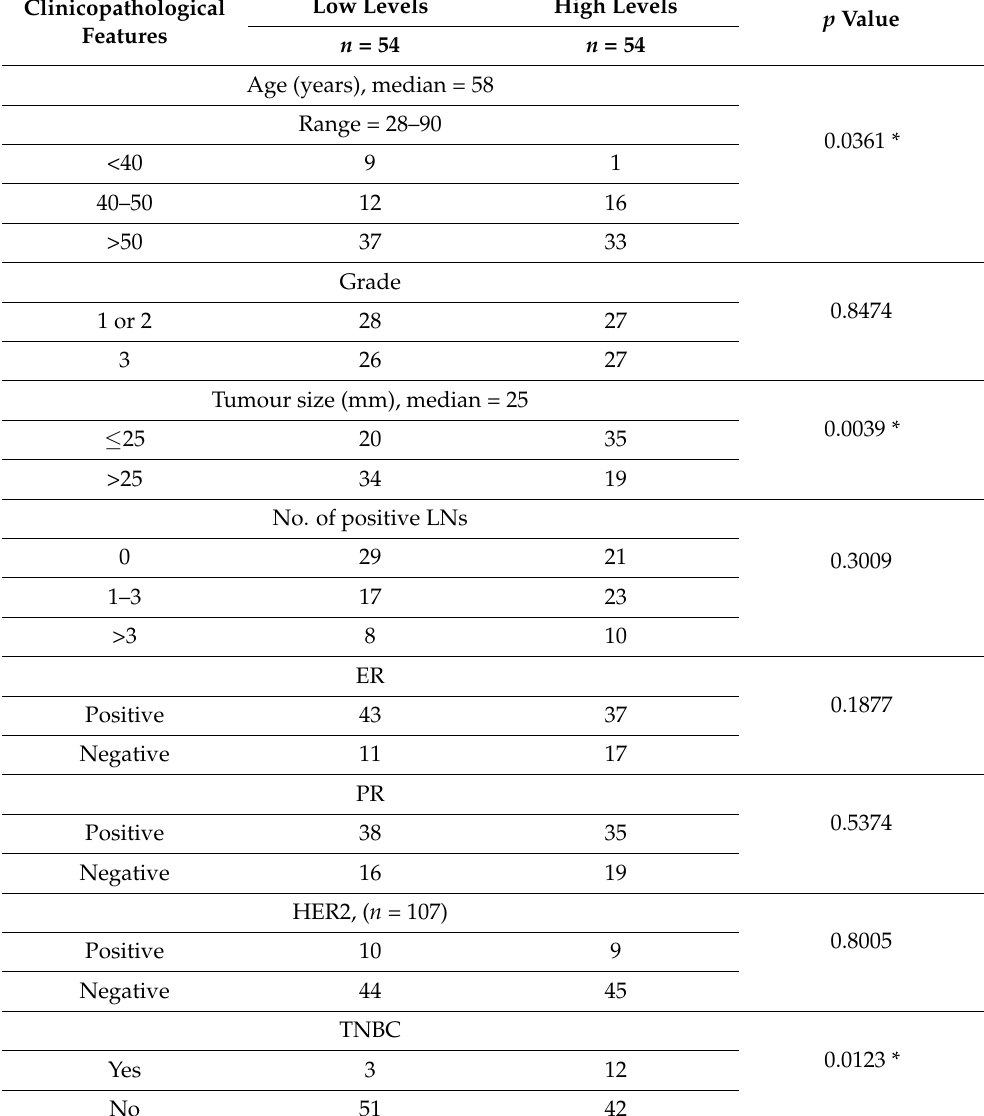
Table 3. Association of high or low levels of p53 with clinicopathological features ( n =